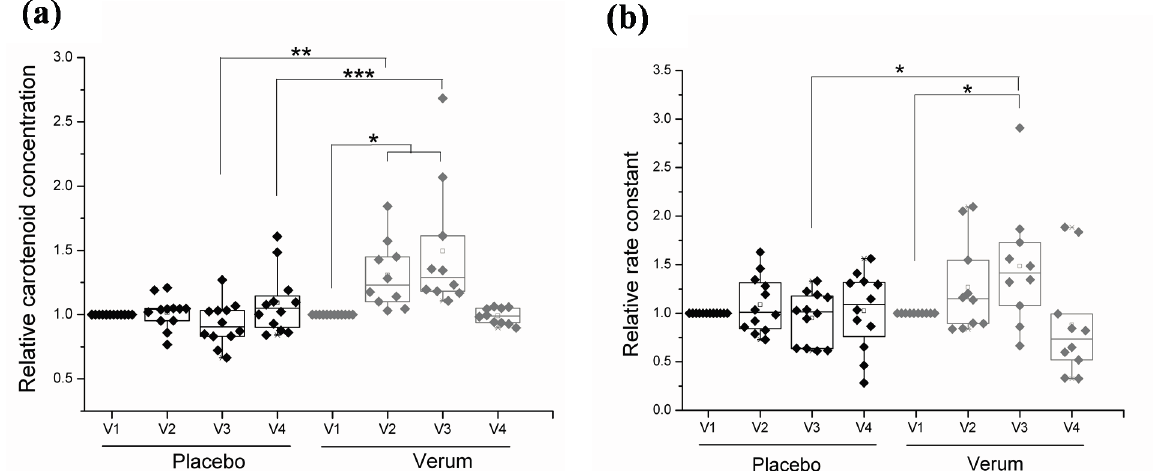
Figure 3. Data taken from visits 1 to 4 (V1, before intake; V2, four weeks after intake; V3, eight weeks after intake; V4, several weeks after discontinuing the intake; ( a ) relative carotenoid concentration; ( b ) relative rate constant [38], * p < 0.05, ** p < 0.01, *** p <